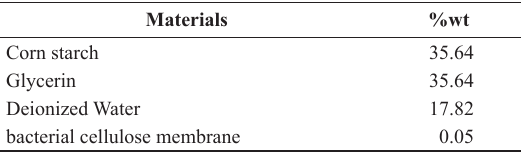
Table 1. Formulation of polymeric membrane.